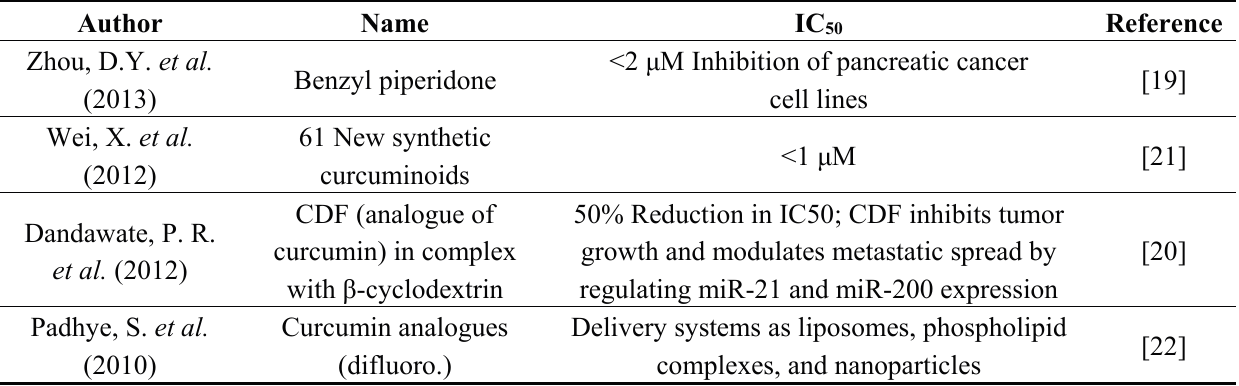
Table 2. New and synthetic curcumin-related